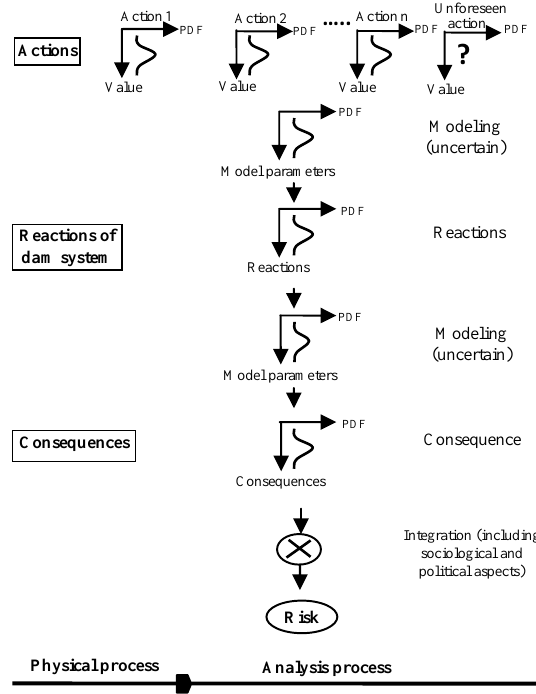
Fig. 1. Risk analysis processes for a typical